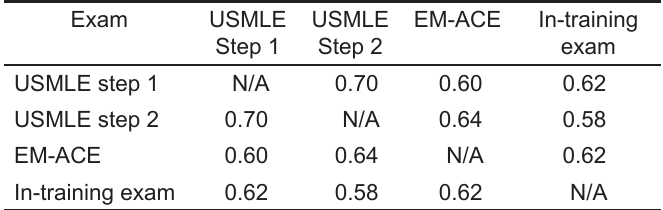
Table 2. Pearson’s correlation coefficients between the United States medical licensing examination (USMLE) Step 1 and Step 2, the emergency medicine advanced clinical exam